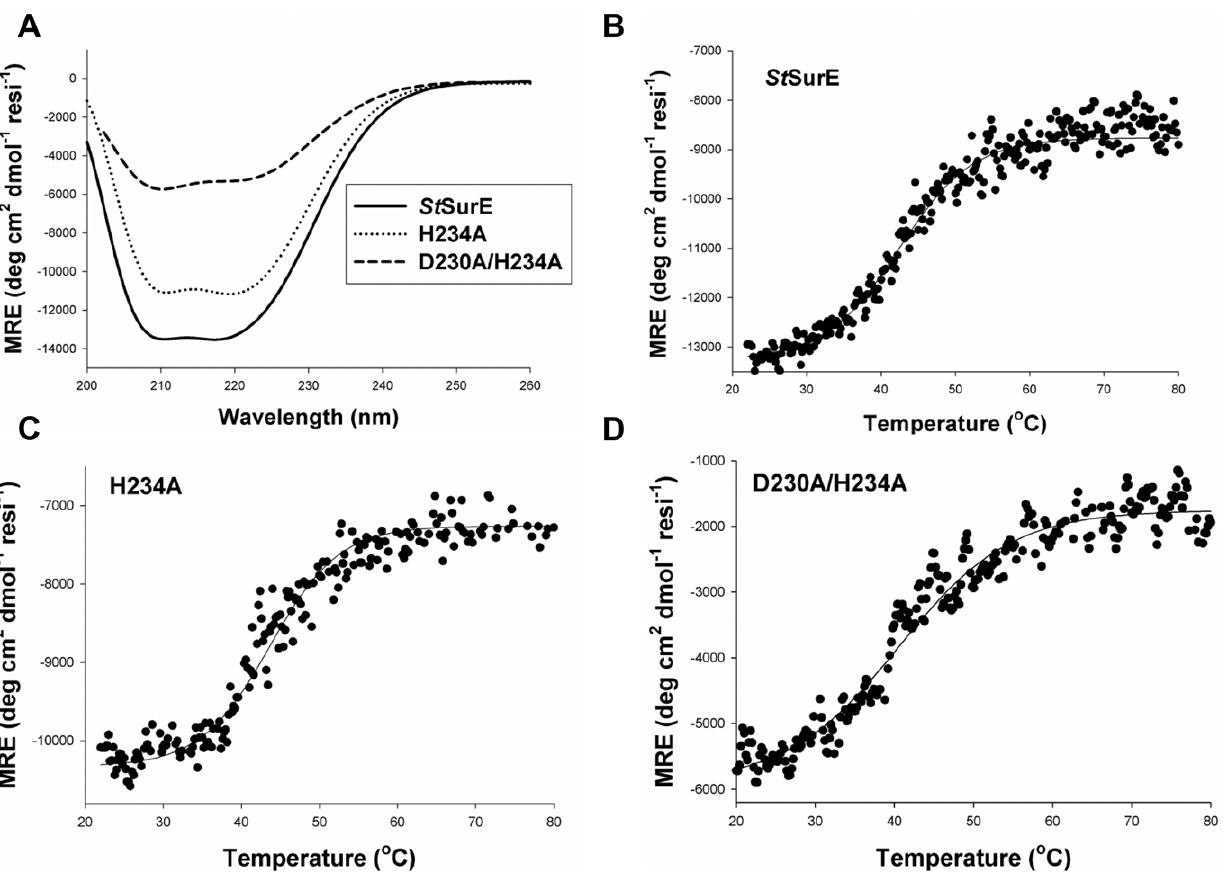
Figure 3. Circular Dichorism (CD) studies of St SurE mutants. A) CD spectra exhibited minima at 208 and 222 nm indicating that the native and the mutants are a / b proteins. B), C) and D) show melting profiles monitored by CD at 208 nm as a function of temperature for native (T m =43 u C), H234A (T m =43 u C) and D230A/H234A (T m =41 u C), respectively in HEPES buffer. Note the broad melting profile of the double mutant.